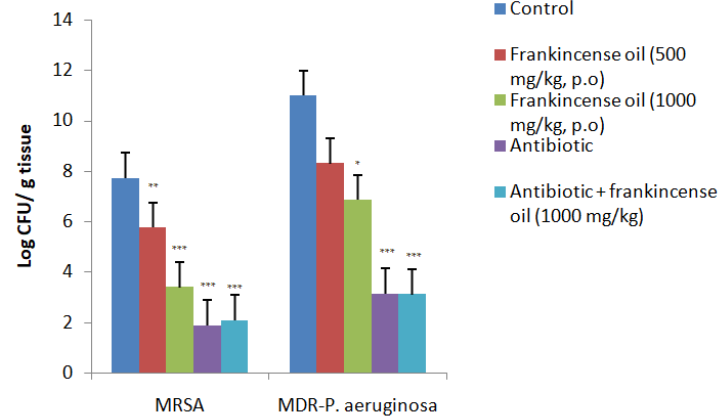
Figure 3. The bacterial load (CFU/g) in the lung tissue after treatment with Frankincense oil. Data shown are mean ± SEM, n = 6, * p < 0.05, ** p < 0.01, *** p < 0.001 when compared to respective controls. There was no significant difference between frankincense oil (500 mg/kg) and MDR- P. aeruginosa control. Antibiotic—imipenem (120 mg/kg, i.p) against MRSA, and gentamicin (10 mg/kg, i.p) against MDR- P. aeruginosa.